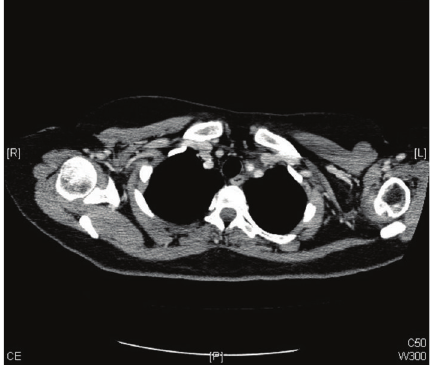
Figure 4: Postchemotherapy CT scan axial images showing a decrease in the size of the left supraclavicular